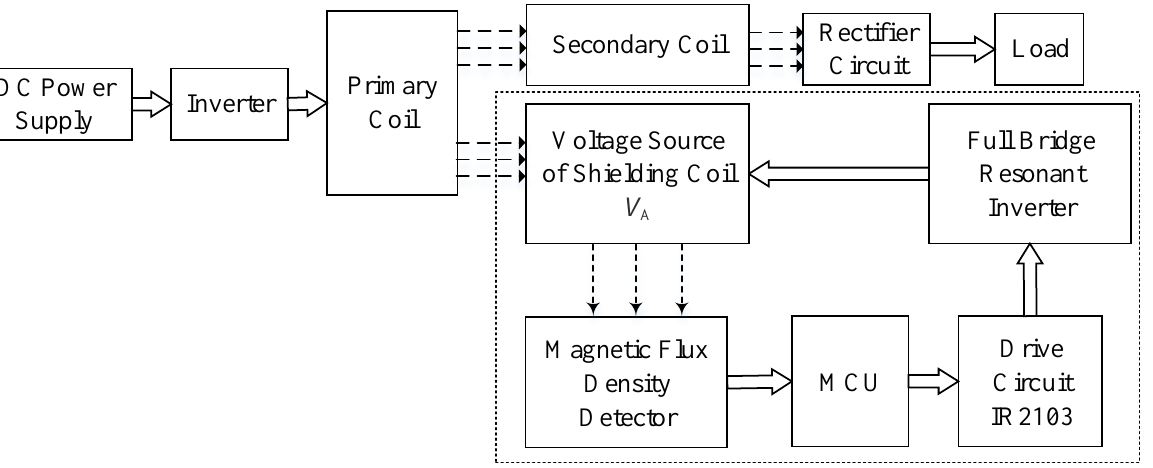
Figure 12. The structural framework of WPT system with double-coil active shielding.